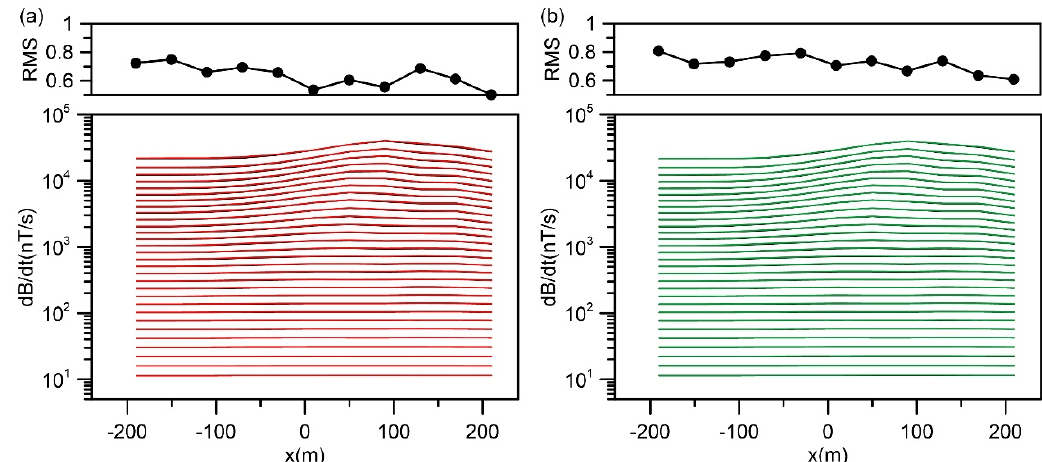
Figure 5. Data fitting and root mean square (RMS) for profile y = 50 m in Figure 3b obtained from the inversion for the synthetic example 1. ( a ) Anisotropic inversion; ( b ) isotropic inversion. The black lines are for the inversion data, while the red and green lines are for predicted data.